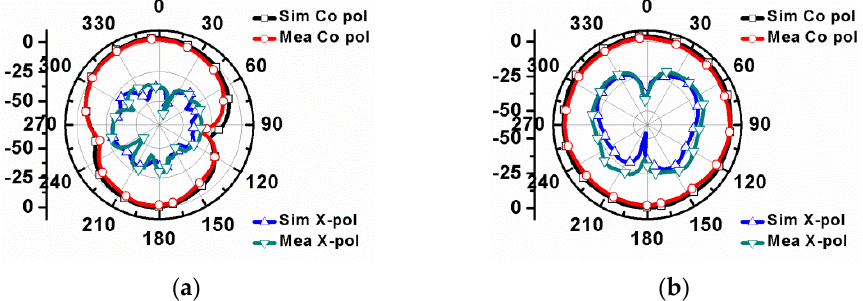
Figure 27. Far-field patterns of the communication antenna linked with port 18 at ( a ) 9 GHz (XZ) and ( b ) 9 GHz (YZ).